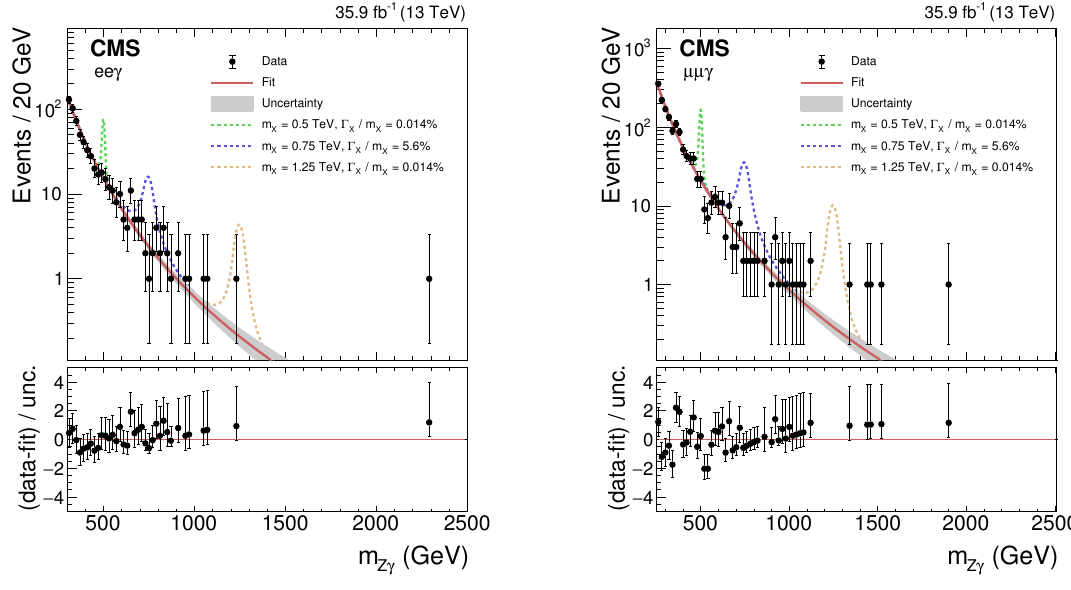
Figure 1 . Observed m Z (cid:13) invariant mass spectra in the ee (cid:13) (left) and (cid:22)(cid:22)(cid:13) (right) channels. The best (cid:12)ts to the background-only hypotheses are represented by the red lines, with their 68% CL uncertainty bands given by the gray shadings. Several narrow and broad signal benchmarks with arbitrary normalization are shown on top of the background prediction with the dashed lines. The lower panels show the di(cid:11)erence between the data and the (cid:12)ts, divided by the uncertainty, which includes the statistical uncertainties in the data and the (cid:12)t. For bins with a small number of entries, the error bars correspond to the Garwood con(cid:12)dence intervals